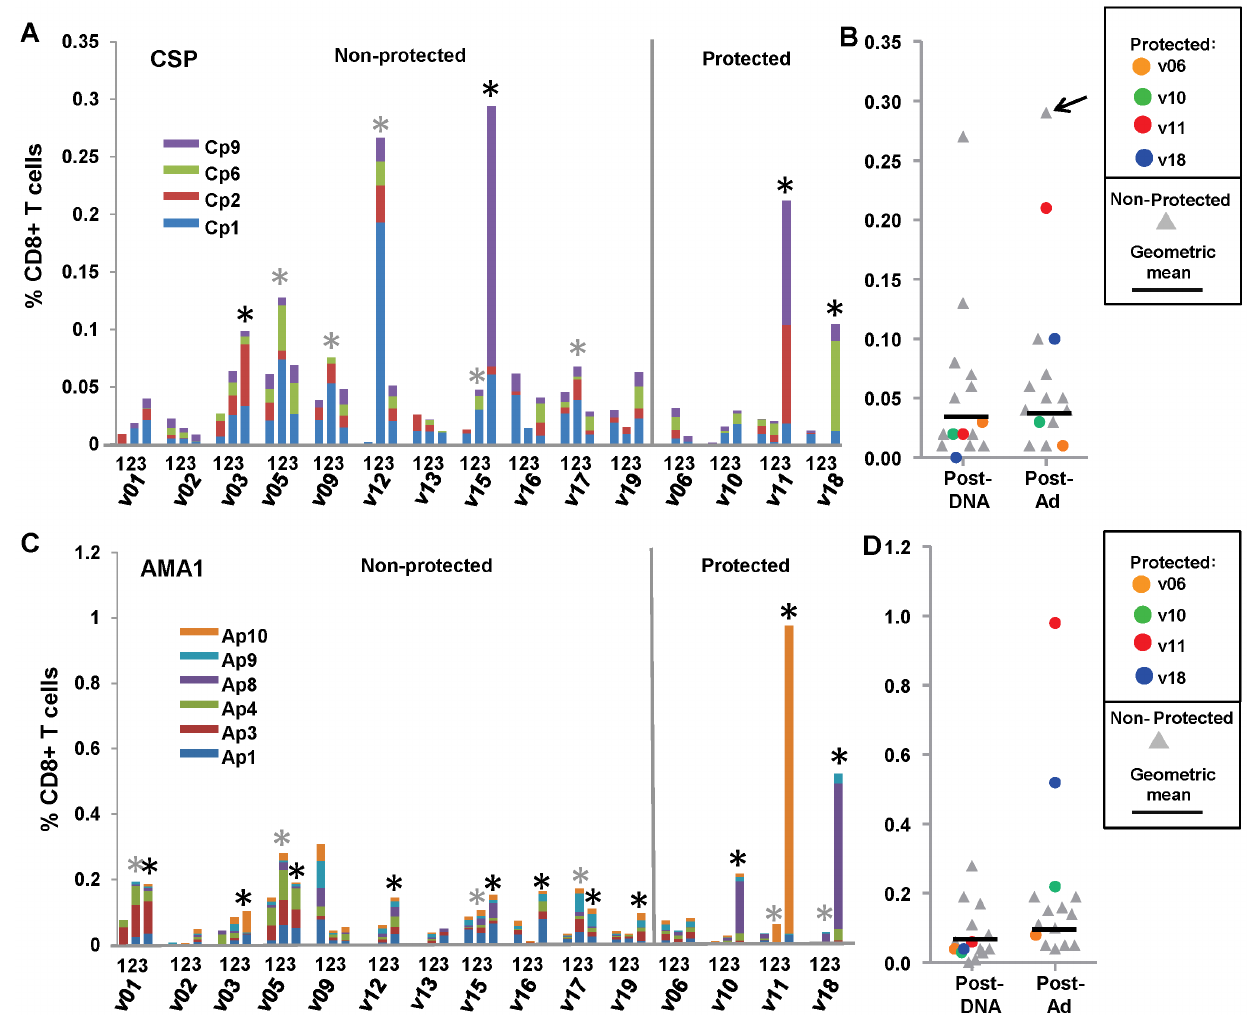
Figure 3. DNA/Ad CD8 + T cell IFN- c activities to CSP and AMA1 peptide pools. Panels A and C: CD8 + T cell IFN- c activities of each volunteer to CSP or AMA1 peptide pools are shown as color coded stacked bars at pre-immunization (1), 28 days after DNA immunization (2) and 22/23 days after the Ad boost (3). *Positive activities (gray: post-DNA: black: post-Ad). Panels B and D: CD8 + T cell IFN- c activities were summed and are shown as color-coded dots. Horizontal bars represent geometric mean activities of non-protected volunteers. The geometric means of summed activities of non-protected volunteers and the activities of each protected volunteer are shown in Table 1. Panel A: CSP: Five non-protected volunteers were positive after DNA immunization, but four volunteers were positive after Ad boost including protected v11 (0.21%) and v18 (0.10%) that were above non-protected volunteers, except v15 that had highest activity (0.29%), whereas protected v06 and v10 were negative. Most activity of v11, v18 and v15 was directed to single CSP peptide pools. Panel B: CSP: Geometric means of non-protected volunteers remained similar after DNA immunization and Ad boost when v11 and v18 were higher than all other volunteers, except v15 (arrow). Panel C: AMA1: Four non-protected volunteers were positive after DNA immunization, and 11 were positive after Ad boost, including protected v10 (0.22%), v11 (0.98%) and v18 (0.52%) that were above non-protected volunteers, whereas protected v06 negative. Most activity of v10, v11 and v18 was directed to single AMA1 peptide pools. Panel D: AMA1: Geometric means of non-protected volunteers rose after Ad boost compared to after DNA immunization, and v10, v11 and v18 higher than all volunteers.